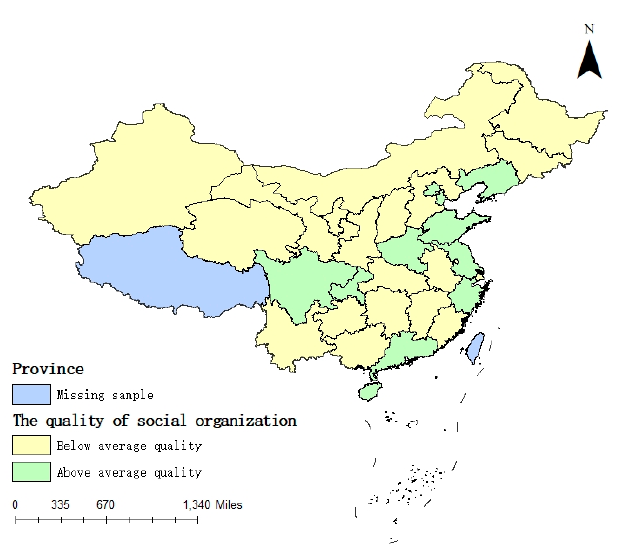
Figure 1. The density of social organizations.